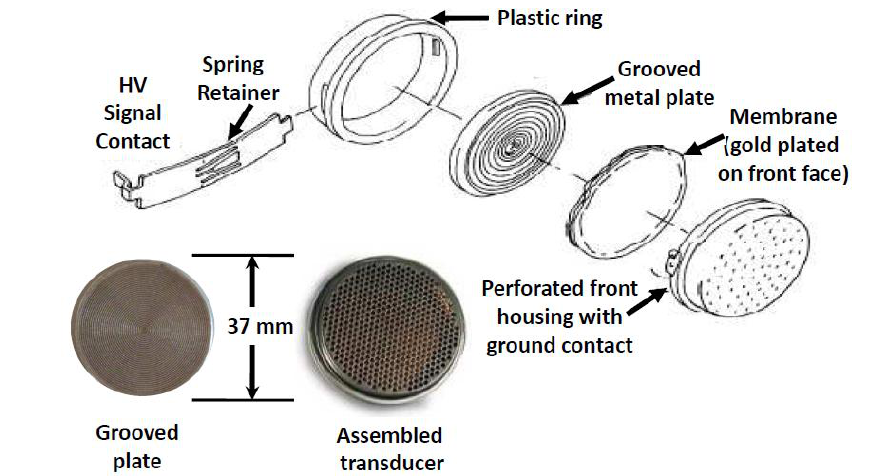
Figure 3. Senscomp model 600 capacitive ultrasonic transducer originally designed by Polaroid ® for autofocus